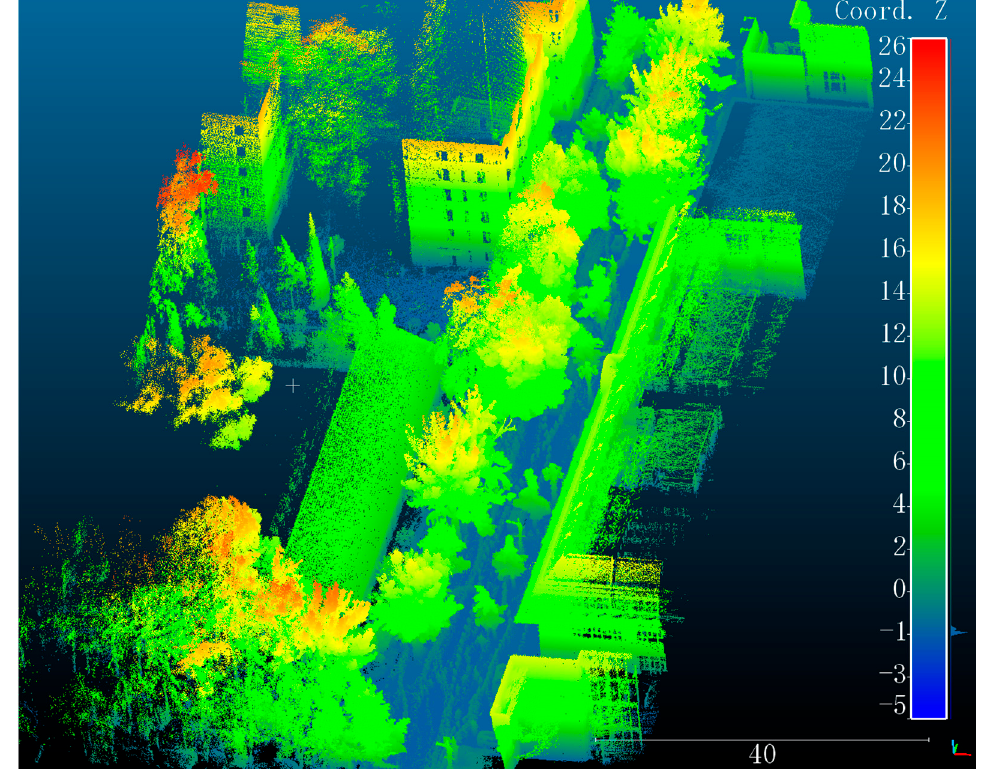
Figure 2. LiDAR point clouds colored based on height in CUMTB-Campus.